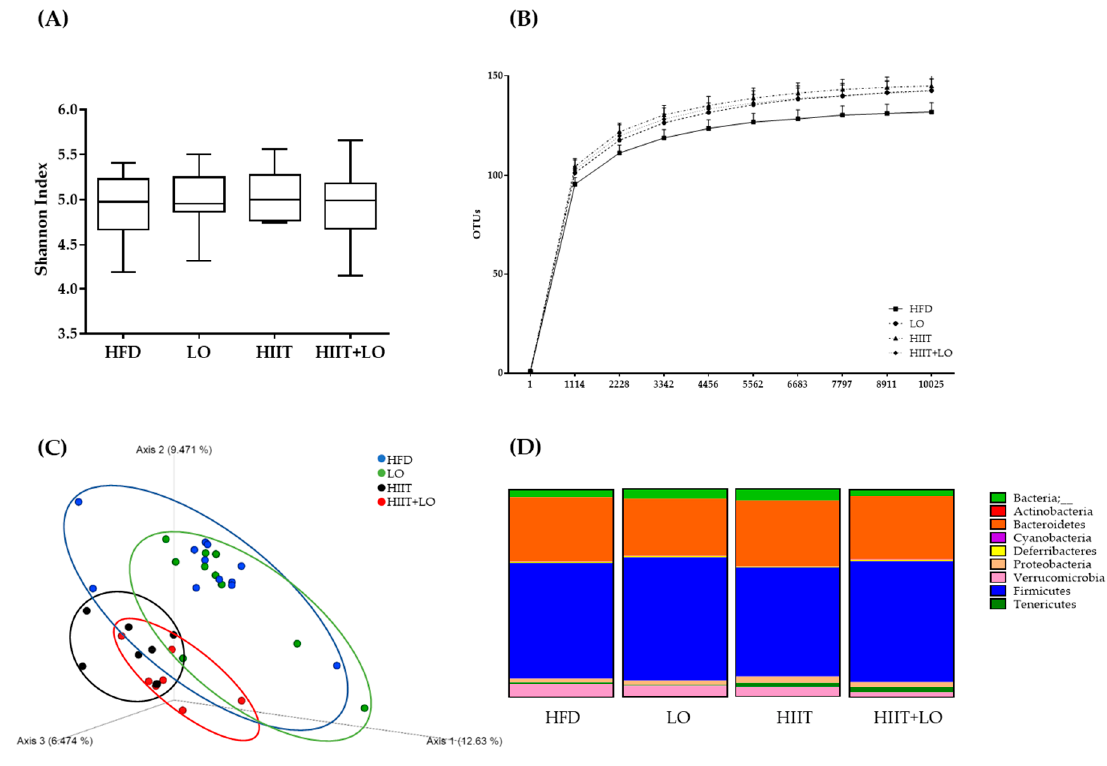
Figure 7. Mucosa-associated microbiota composition analyzed by 16S rRNA gene sequencing in colon DNA samples (Illumina MiSeq system) from the four groups: HFD ( n = 12), LO ( n = 11), HIIT ( n = 7), and HIIT + LO ( n = 8) at the end of phase 2 (training and/or LO supplementation for 12 weeks). ( A ) Shannon index, ( B ) operational taxonomic units (OTUs) with a rarefaction depth of 10,025 sequences, ( C ) unweighted UniFrac analysis, and ( D ) phylum distribution (%).